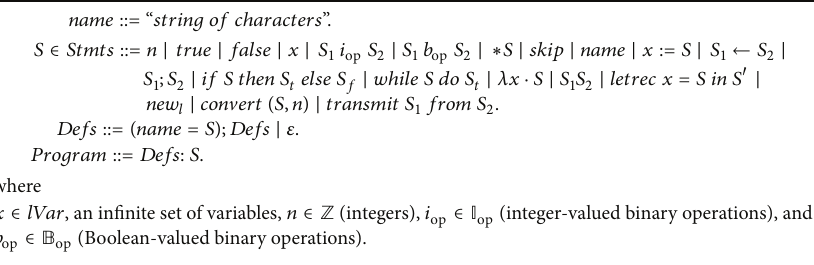
Figure 2: The programming language 𝑤ℎ𝑖𝑙𝑒 𝑑 .